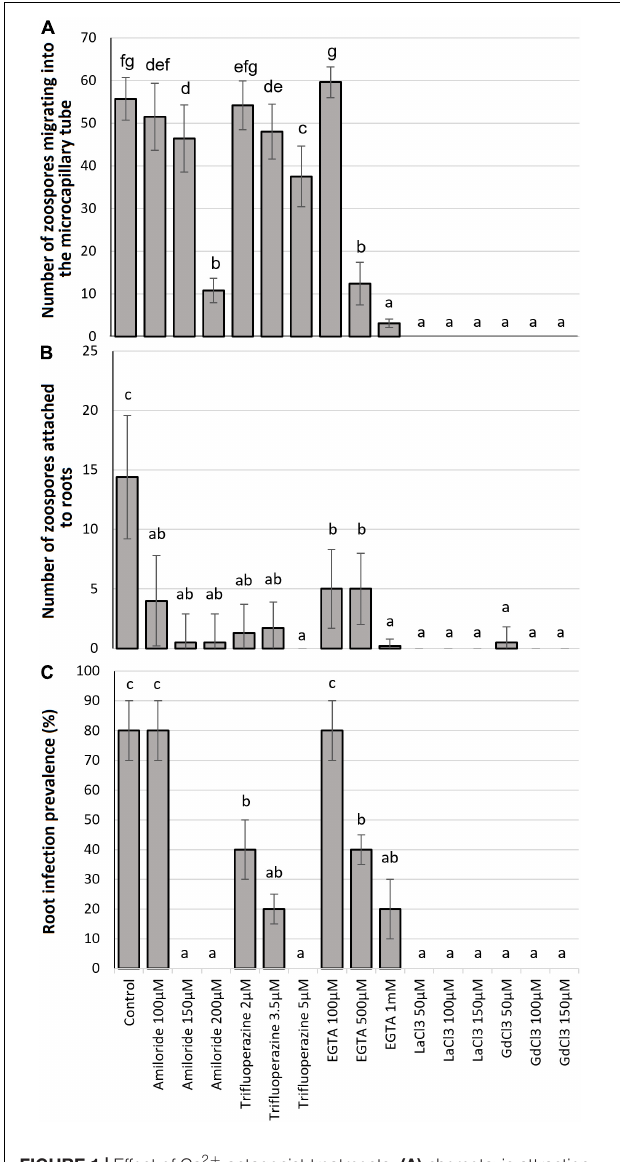
FIGURE 1 | Effect of Ca 2 + antagonist treatments: (A) chemotaxic attraction of zoospores to 0.01 M glutamine in a microcapillary assay; (B) zoospore attachment to potato roots after 24-h incubation; and (C) root infection prevalence 8 weeks after challenge. Bars headed with the same lowercase letter are not statistically